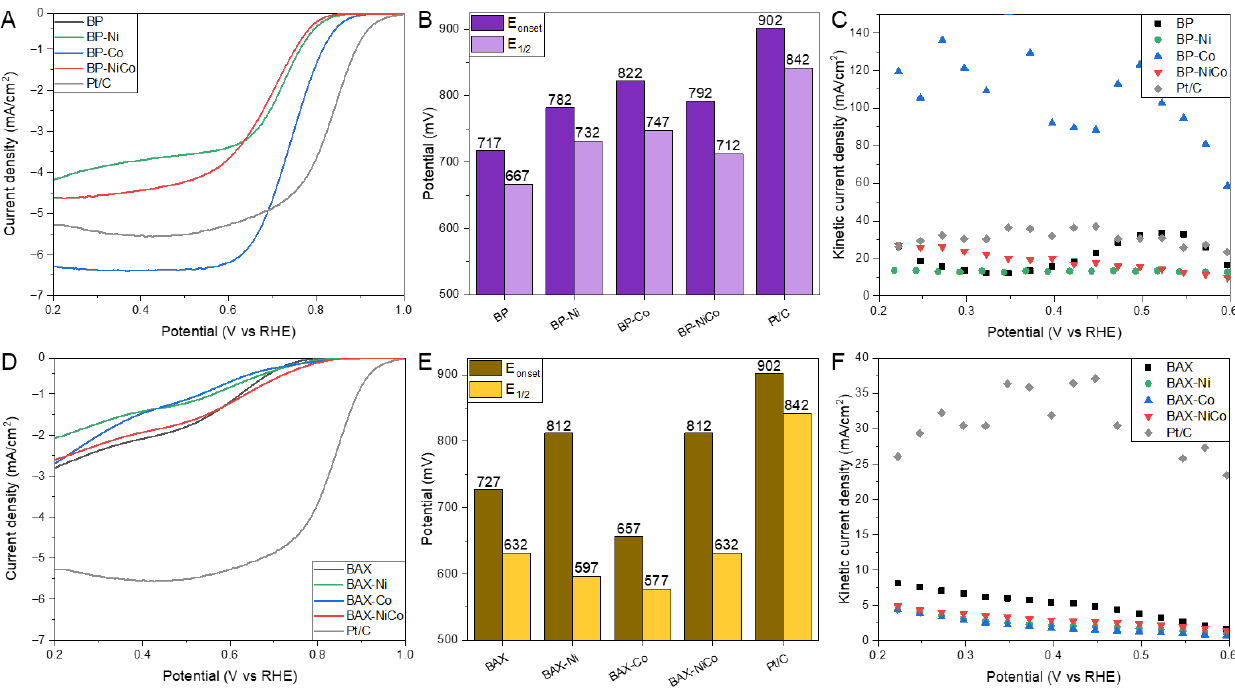
Figure 2. Current density for the BP series samples ( A ) and the BAX ones ( D ); onset potentials for the BP series samples ( B ) and the BAX ones ( E ); the kinetic current densities calculated using Koutecky–Levich Equation for the BP series samples ( C ) and the BAX one ( F ). The LSV curves for the BAX series show marked inferiority in the current